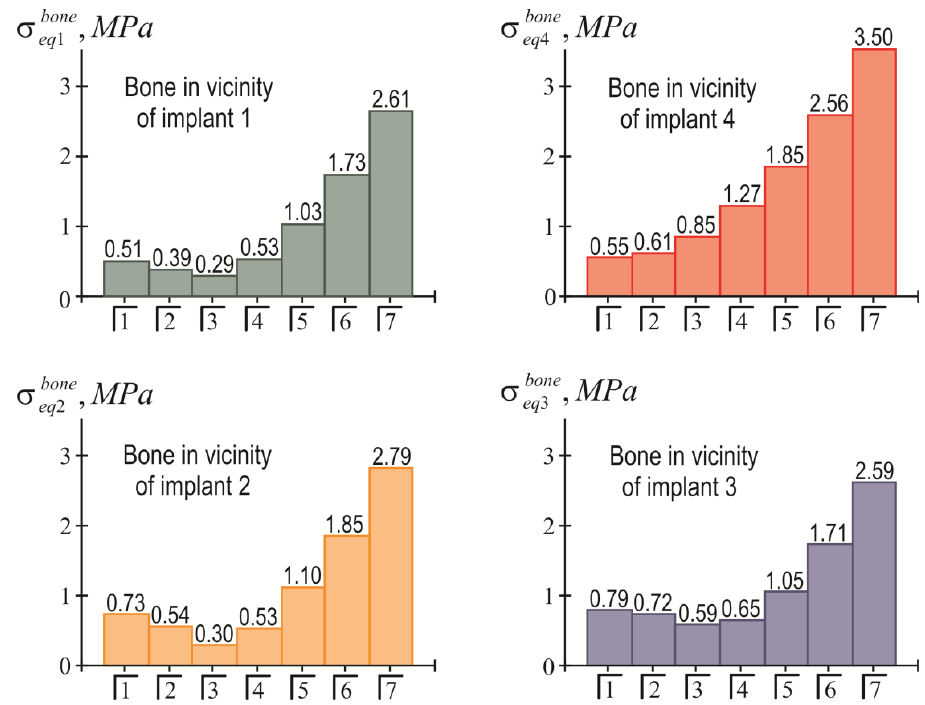
Figure 15. Dependence of maximum equivalent stresses in bone tissue on the location of the mas- tication load (the second variant of implant placement).